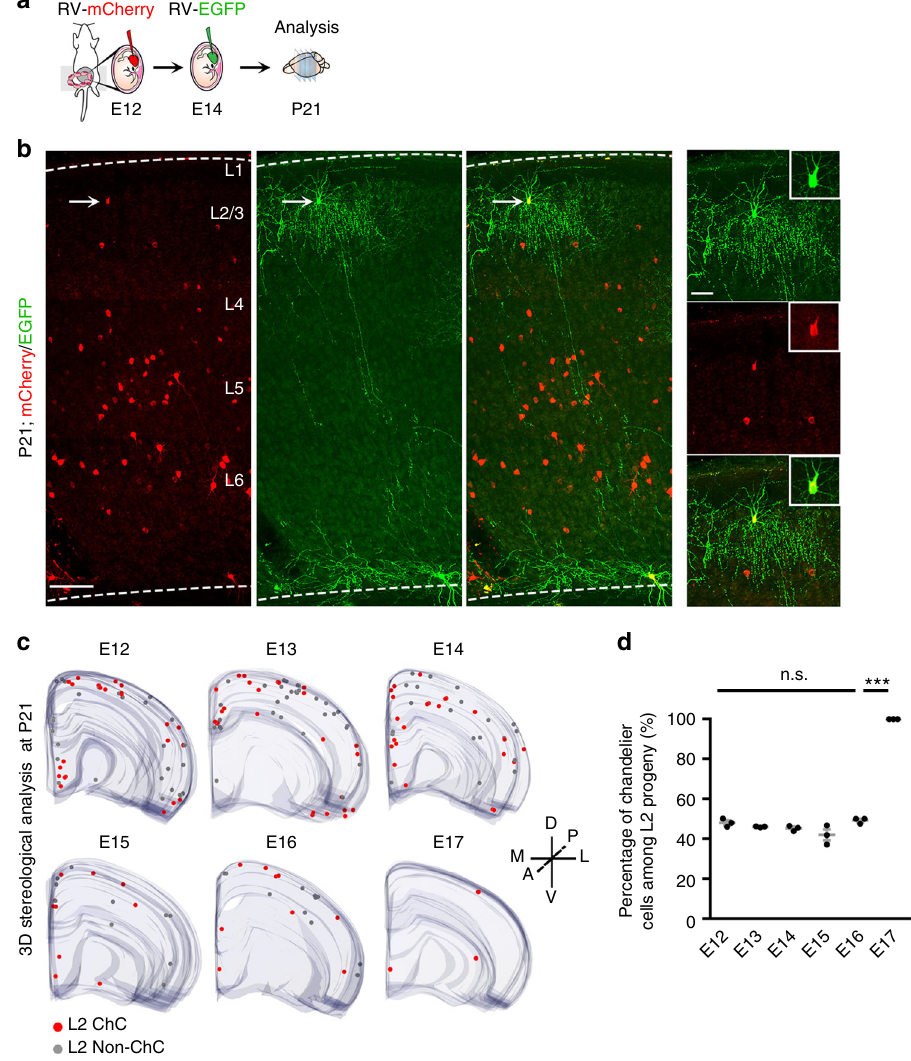
Fig. 4 Consecutive divisions of NKX2.1 + MGE/PoA RGPs generate super fi cial layer chandelier cells. a Schematic of the experimental design. Animals received in utero injection of mCherry-retroviruses and EGFP-retroviruses at E12 and E14, respectively, were analyzed at P21. b Images of P21 neocortex stained for mCherry (red) and EGFP (green). The arrows indicate a super fi cial layer chandelier cell expressing both mCherry and EGFP. High magni fi cation images of the chandelier cells are shown to the right. Broken lines indicate the pial surface and white matter (WM) boundaries. L, layer. Scale bars: 150 µ m and 50 µ m. c 3D reconstruction images of the neocortical hemispheres that received in utero retrovirus injection at E12-E17. Red and gray dots represent EGFP-expressing chandelier and non-chandelier cells in L2, respectively. A anterior, P posterior, D dorsal, V ventral, M medial, L lateral. d Percentage of chandelier cells among EGFP-expressing interneurons in L2. Gray lines represent mean ± SEM. Black dots represent individual brains ( n = 3 per time point). *** P = 0.0003 (E16 vs. E17); n.s., not signi fi cant (E12 vs. E13, P = 0.2258; E13 vs. E14, P = 0.4920; E14 vs. E15, P = 0.3375; E15 vs. E16, P =